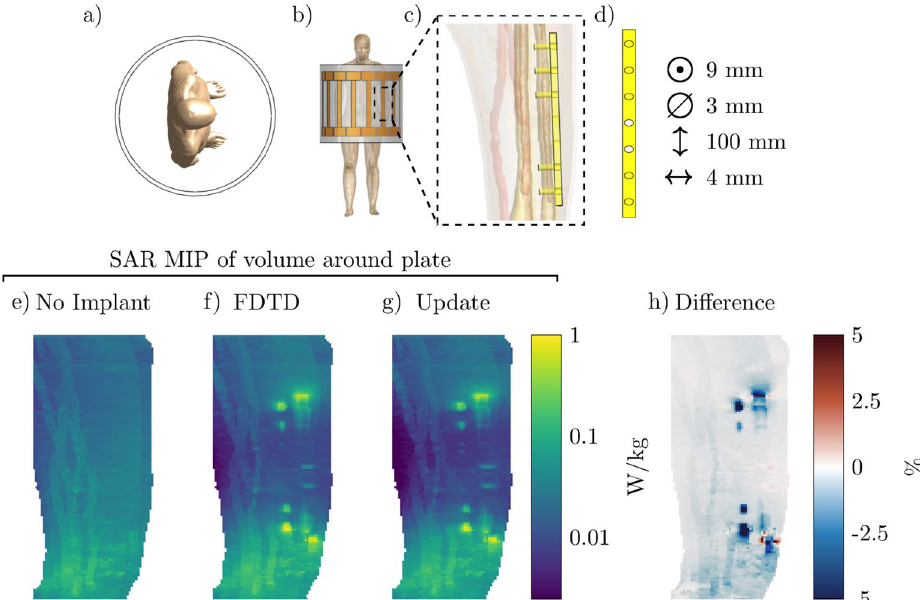
Figure 5. Proposed method applied to calculate the SAR increase for an orthopedic plate with screws. ( a ) and ( b ) Transverse and coronal view of the simulated setup, respectively. ( c ) & ( d ) The model of the simulated orthopedic implant. ( e ) The MIP of the local SAR without implant. ( f ) and ( g ) The MIPs of the local SAR with the implant present using the FDTD and the proposed method respectively. ( h ) The MIPs of the difference between the FDTD and the proposed method.